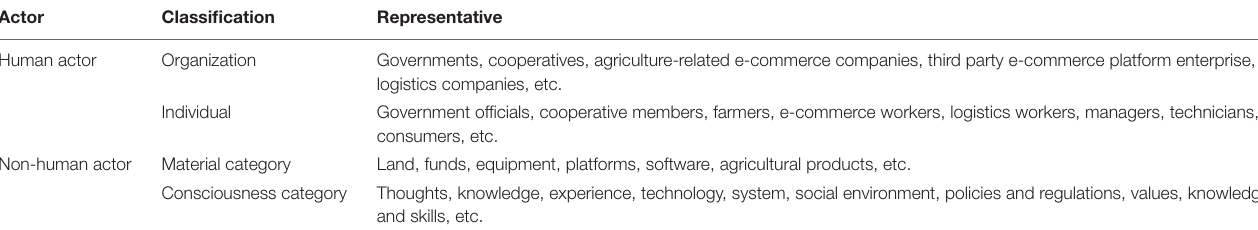
FIGURE 2 | An integrated evolution model: E-commerce poverty alleviation actor network (EPAAN) based on cooperatives. TABLE 2 | The actors composition of e-commerce poverty alleviation actor network